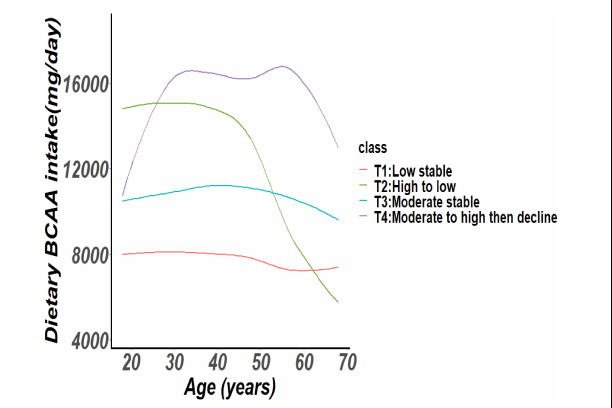
FIGURE 1 | Trajectories of dietary branched-chain amino acids (BCAA) consumption (n = 6,810) in the Chinese adults from the CHNS by LCTM. BCAA, Branched chain amino acids; CHNS, China Health and Nutrition Survey; LCTM, Latent class trajectory modelling.